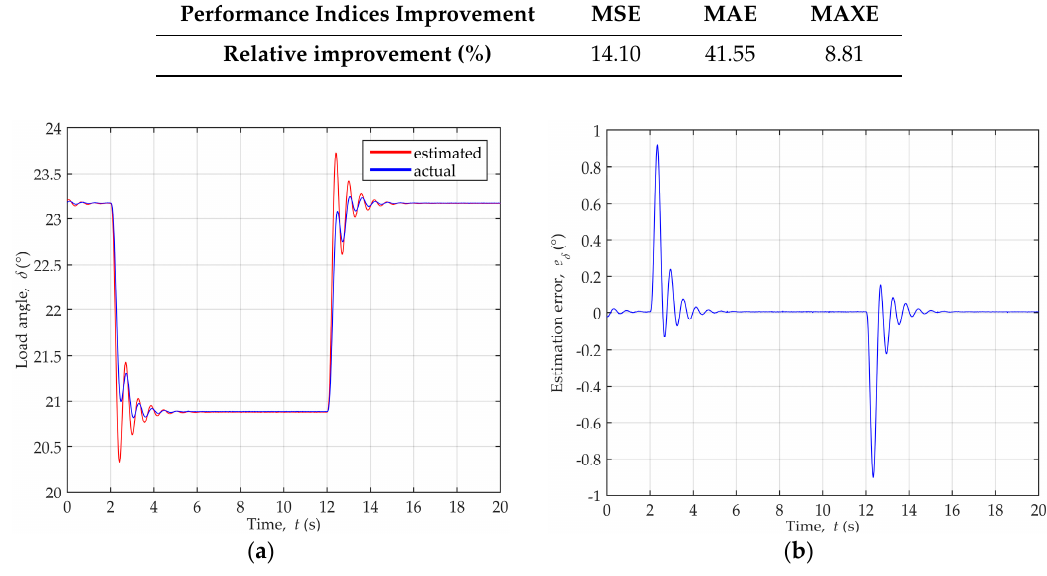
Figure 15. Load angle variation during dynamic disturbances of active power for generator operating point P = 0.89, Q = 0.41 ind.: ( a ) Comparison of the actual and estimated load angle values; ( b ) Load angle estimation error.